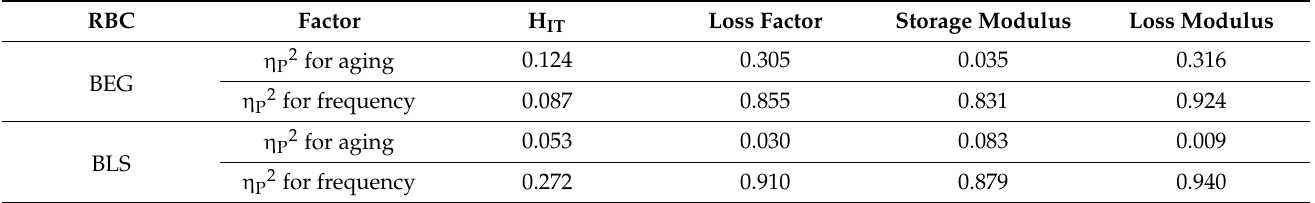
Table 3. Effect strength of the factors aging and frequency on each individual RBC, defined by the parameter η P2 . All effects are significant ( p < 0.001).